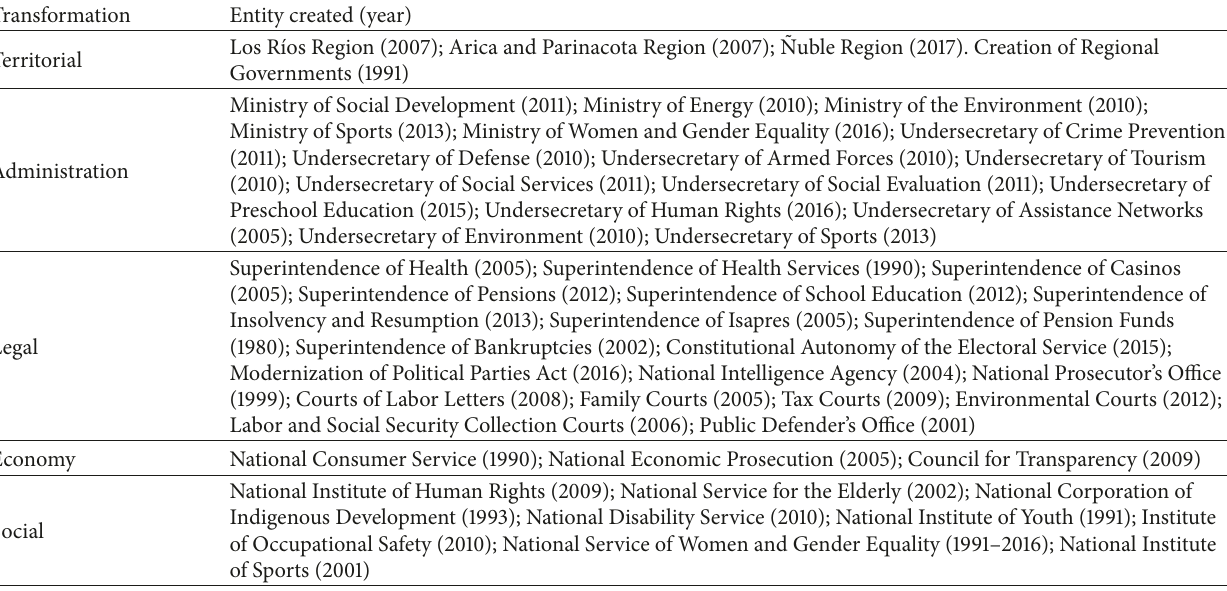
Table 2: Main entities created in Chile in the last 27 years (authors’ own elaboration).